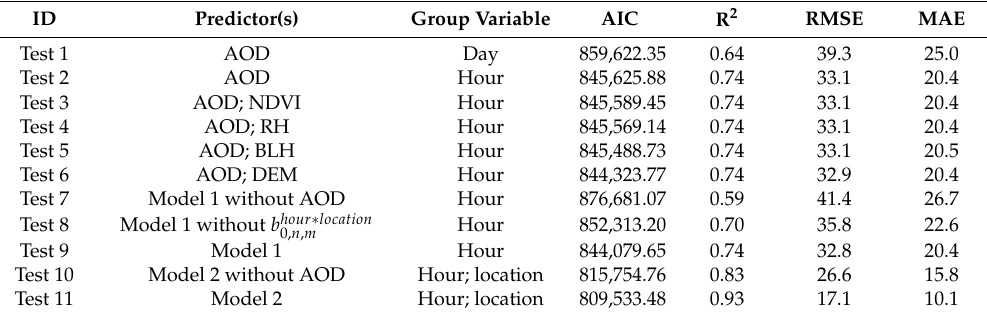
Table 3. Result comparison of model fitting with different predictors.